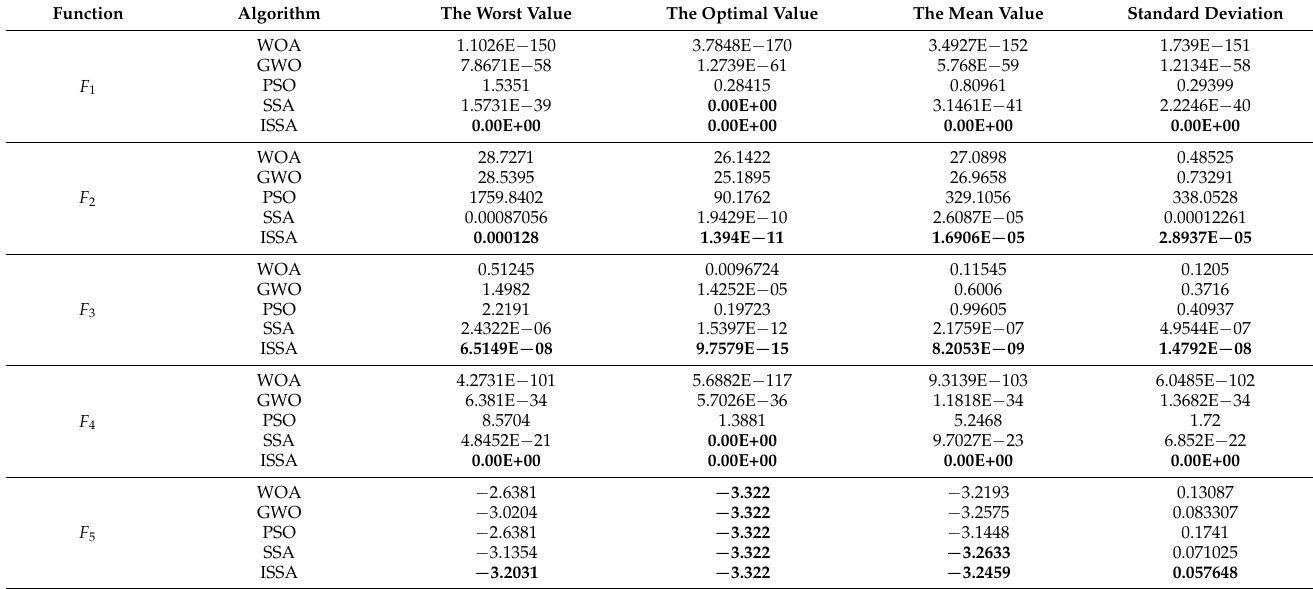
Table 2. Test function result